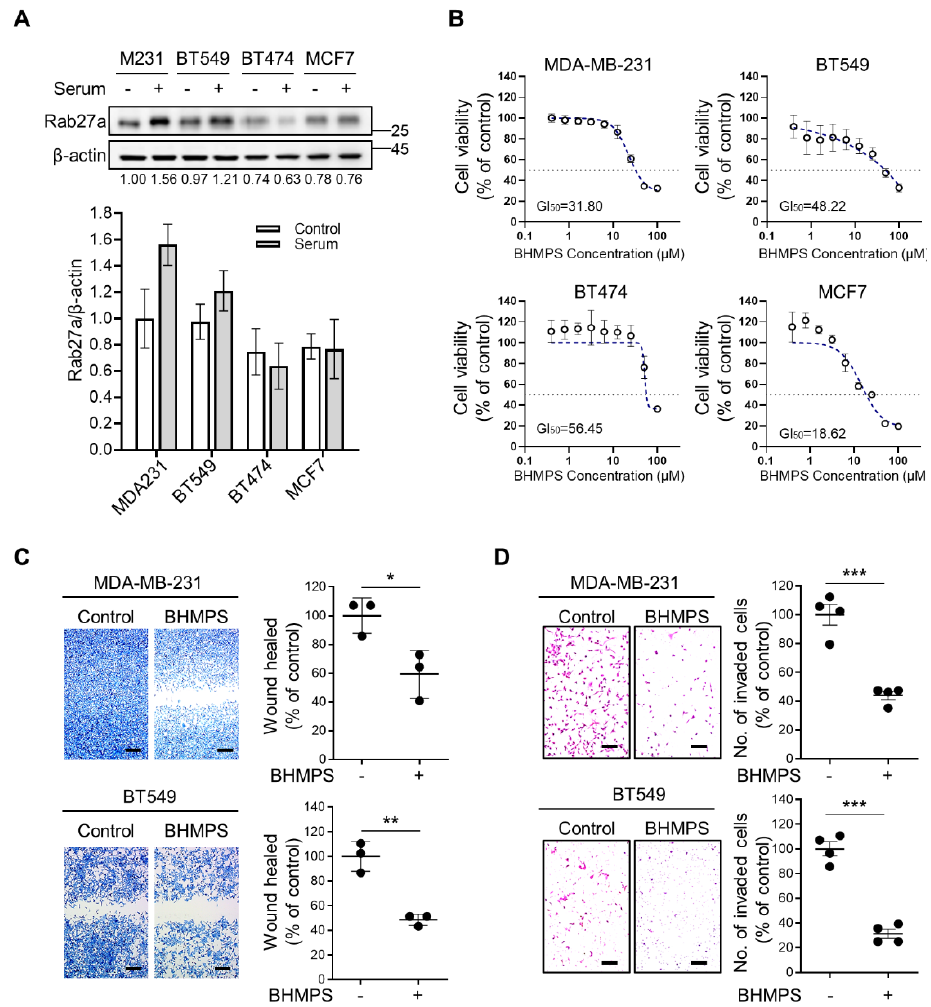
Figure 1. BHMPS inhibits migration and invasion in breast cancer cells. ( A ) Basal levels of Rab27a in several breast cancer cell lines were identified using western blotting. The uncropped images are shown in Supplementary Materials. Relative Rab27a levels were quantified using densitometry with ImageJ software, normalized to β -actin level, and expressed as fold-change compared to that of the MDA-MB-231 control. Data represent the average of three independent experiments. ( B ) MTT assays were performed to determine cell viability. Cells were treated with the indicated concentrations of BHMPS (0–100 µM) for 24 h. Data shown are the means ± SD of three independent experiments. ( C ) MDA-MB-231 and BT549 cells were seeded into 6-well plates and scratched using a 200 µL pipette tip. The cells were treated with 10 µM of BHMPS for 24 h, after which the cells were stained and photographed using a microscope at 40× magnification (Scale bars 250 µm). Percentage wound healing was quantified by measuring the distance of the wound. Data shown are means ± SD of three independent experiments; * p < 0.05 and ** p < 0.01 compared with the control. ( D ) MDA-MB-231 and BT549 cells were seeded in a Matrigel-coated upper chamber. The lower chamber was treated with 10 µM of BHMPS, and the cells were allowed to invade through a Transwell membrane for 24 h. The cells were stained and photographed using a microscope at a magnification of 40× (Scale bars 250 µm). The invaded cells were counted in five randomly selected regions in each experiment. Data shown are means ± SD of four independent experiments; *** p < 0.001 compared with the